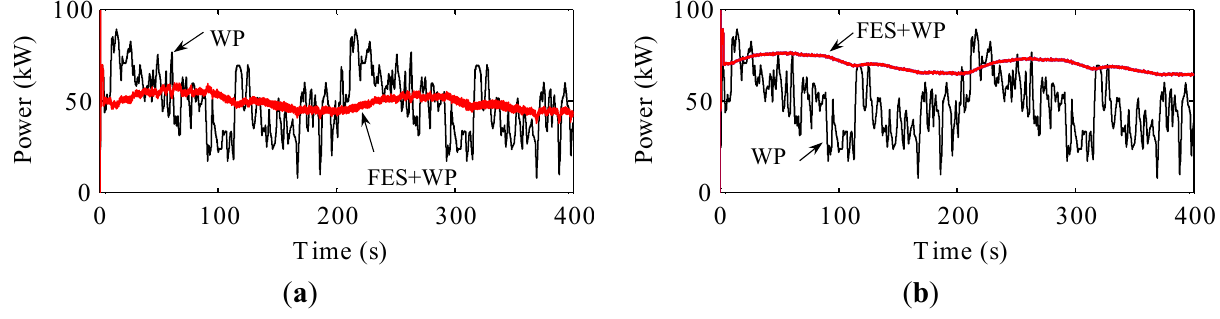
Figure 7. FES power and wind power: ( a ) the conventional FES system; ( b ) the proposed FES